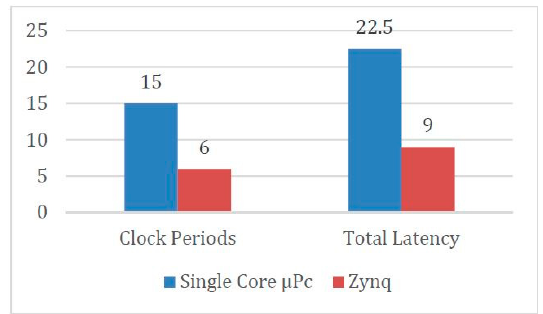
Figure 15. Comparison between single core processor and MPSoC.